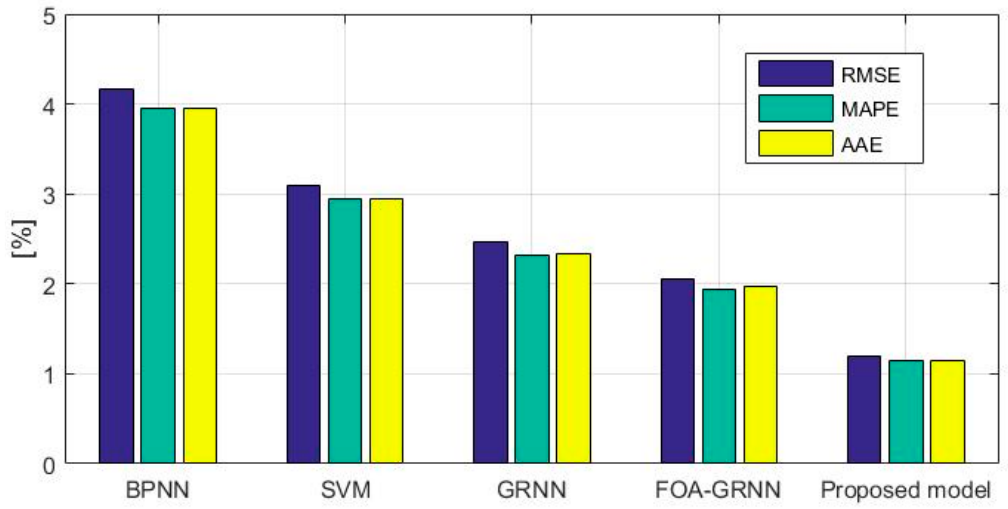
Figure 12. The relative error curves of each method.